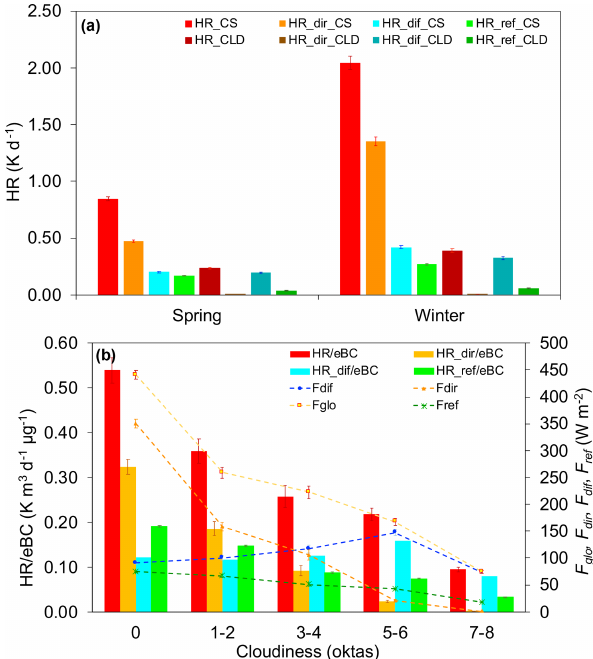
Figure 9. Monthly averaged values of (a) HR values and their di- rect, diffuse and reflected components (HR dir , HR dif and HR ref ) during winter and spring both in clear-sky (CS; 0 oktas) and cloudy (CLD; 7–8 oktas) conditions. (b) HR / eBC values together with their direct, diffuse and reflected components (HR dir / eBC, HR dif / eBC and HR ref / eBC); the direct, diffuse and reflected irra- diance ( F dir , F dir and F dif ); and the global irradiance ( F glo ).